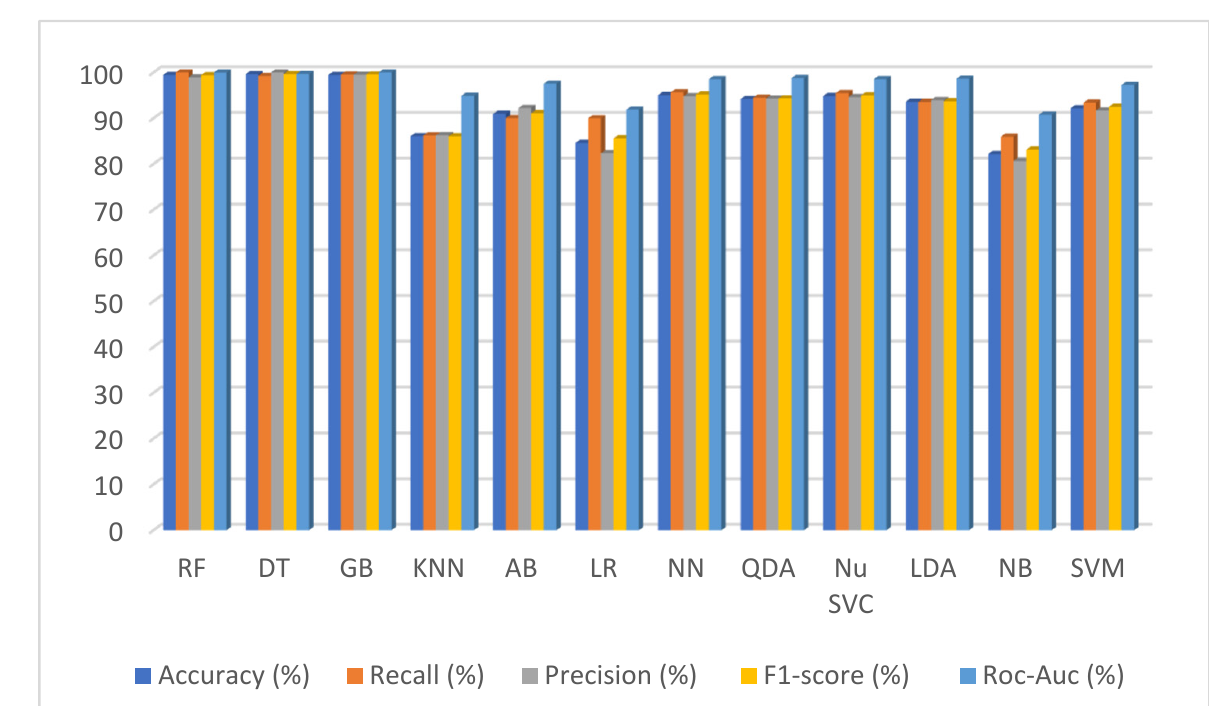
Figure 14. Performance of ML classifier using 5- fold cross-validation.